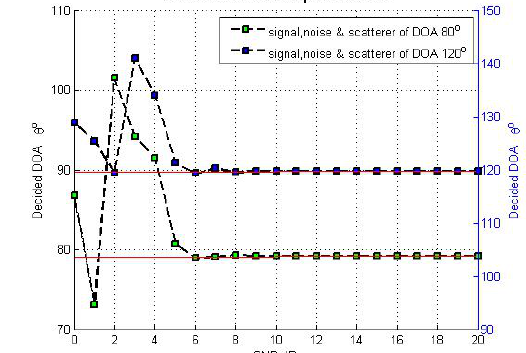
Figure 9: Convergence of decided